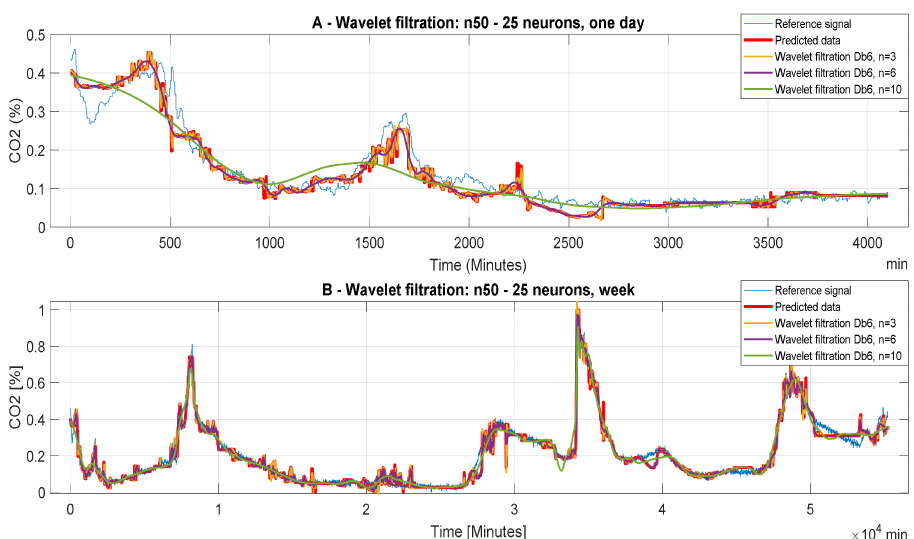
Figure 8. CO 2 concentration for di ff erent time periods using Model 3 (n50 to 25 neurons). Wavelet-based filtration is performed for Db6 with level of decomposition, n = 3, 6, and 10. Concentration for di ff erent time periods using ANN model